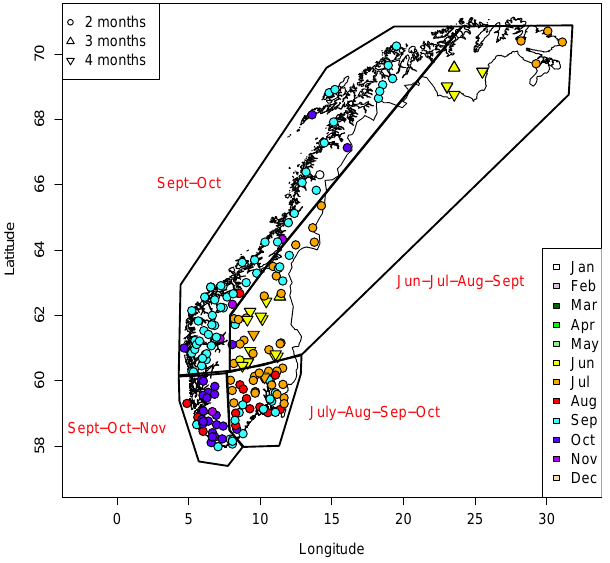
Figure 4. Length of the season-at-risk (shapes) and first month of the season (color code in the inset) for each station, with model MEWP ( 0 . 5 , 2 , 8 ) . The local definition of seasons is used in Sect. 4.2.1, while the regional definition, with four regions, is used in Sect.